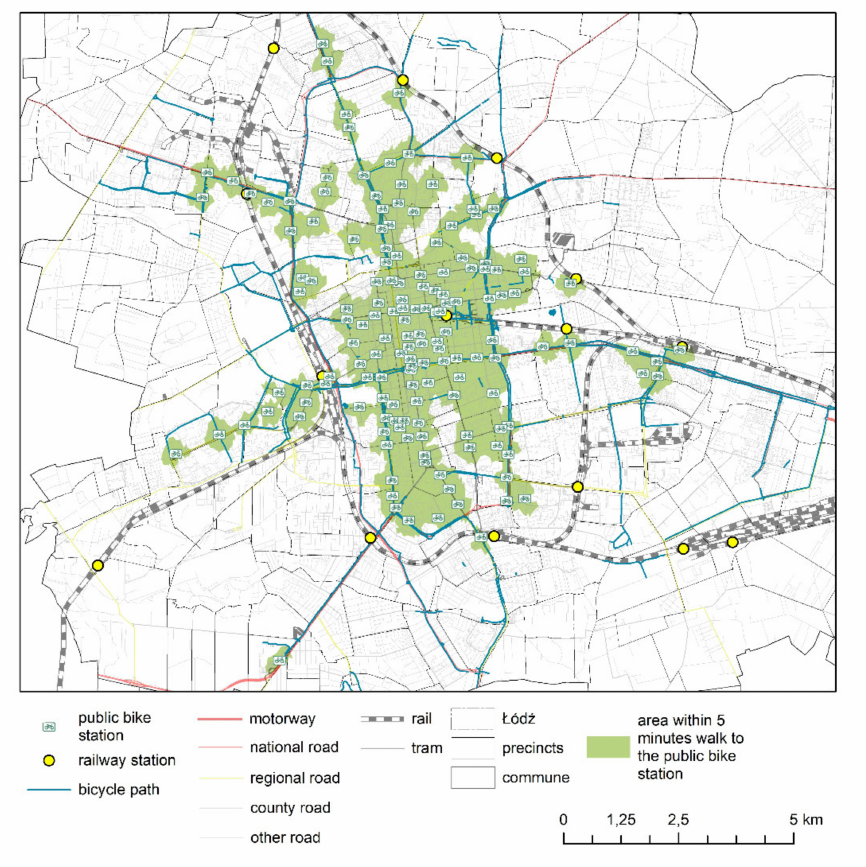
Figure 4. Location of the ŁPB docking stations and cycle paths against other elements of the transport infrastructure in Ł ó d´z; Source: own elaboration based on the Ł ó d´z City Hall, OpenStreetMap, and the Database of Topographic